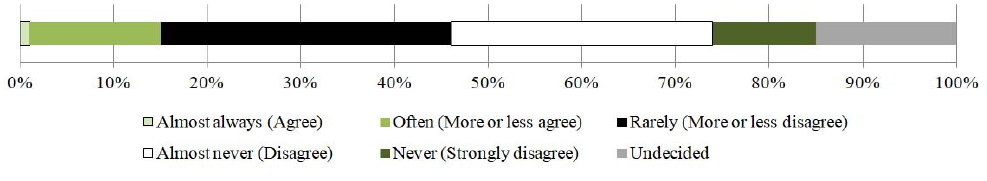
Figure 4. Respondents who bought organic vegetables